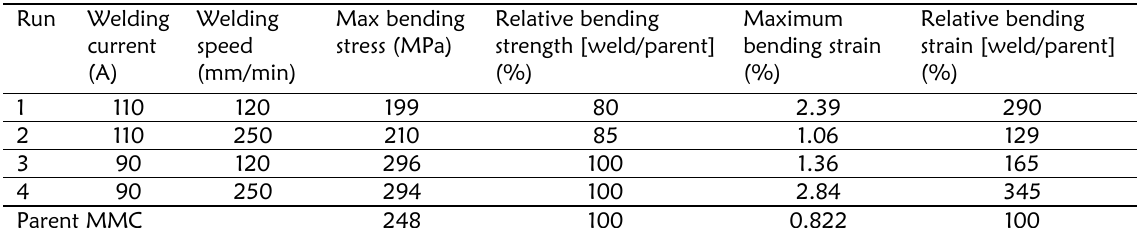
Table 5: Factorial experiment. Four point bending test results without replicate.